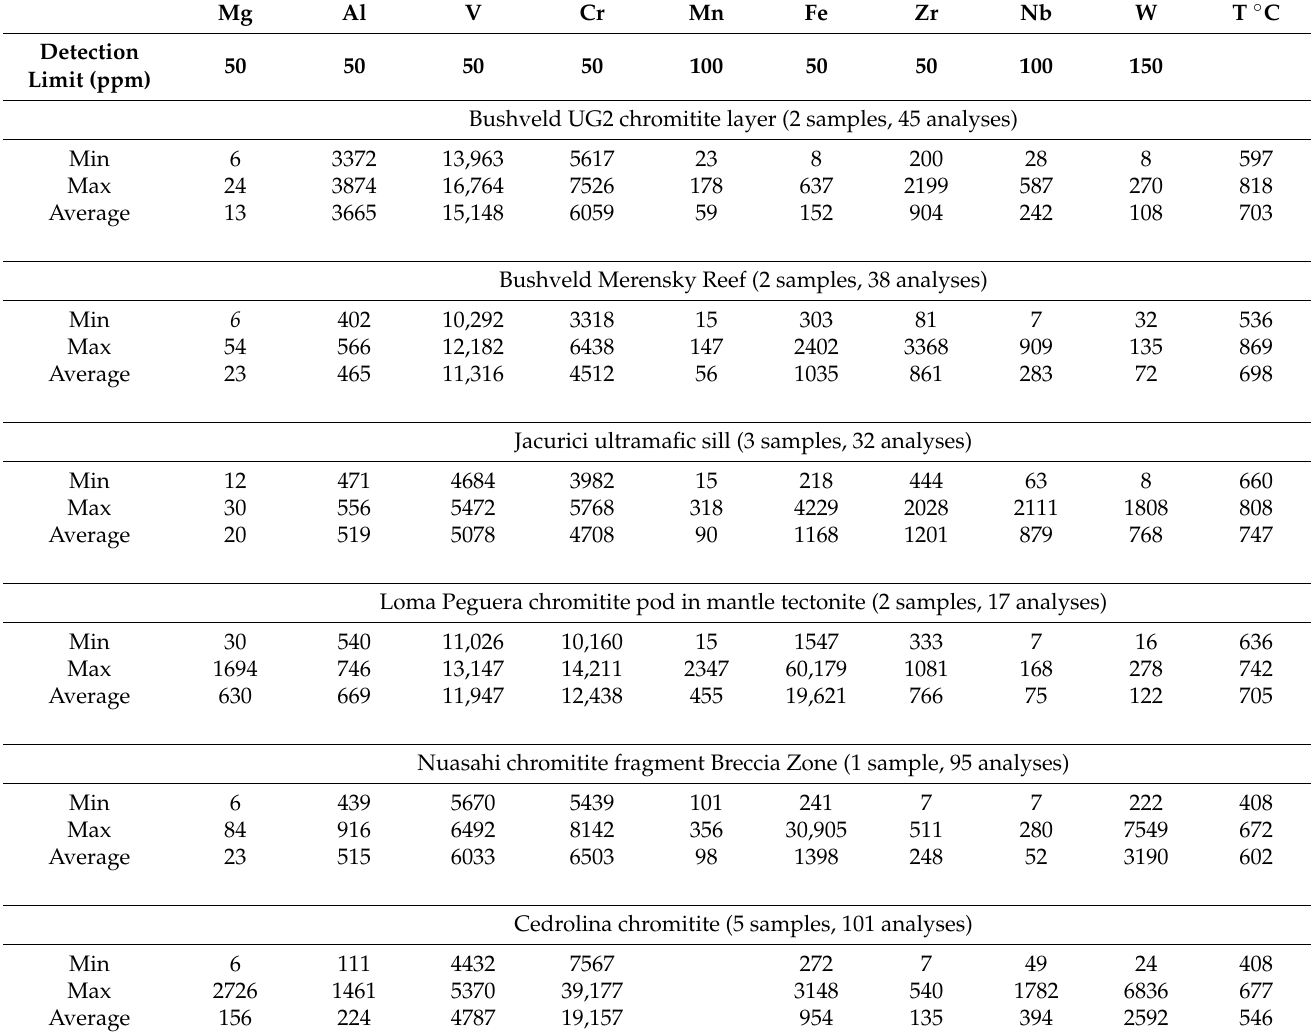
Table 4. Statistics of trace element concentration (ppm) and Zr-in-rutile based temperature for 328 rutile analyses. Mg Al V Cr Mn Detection